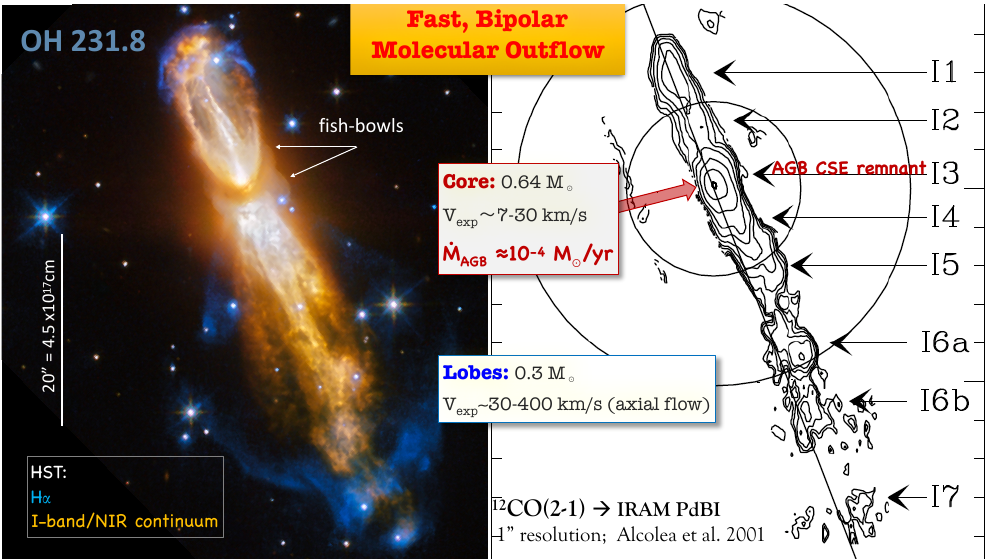
Figure 1. ( Left ) False color HST image of the reflection nebulosity (red-to-yellow) and H α -emitting lobes (blue) of OH231.8 + 4.2 (Credit: ESA/Hubble & NASA. Acknowledgement: Judy Schmidt). North is up. Two faint, bubble-like features ( fish-bowls ) with molecular counterparts in our ALMA data are indicated—see Section 3.3. ( Right ) ALMA order-zero moment maps of 12 CO(2-1) integrated over the full width of the line profile adapted from [17]. The mass and expansion velocity of the low-velocity core and the fast, bipolar lobes are indicated. The distance to OH231.8 + 4.2 is d ∼ 1500pc. The lobes are tilted with respect to the plane of the sky by i ∼ 35 ◦ , with the North lobe being the